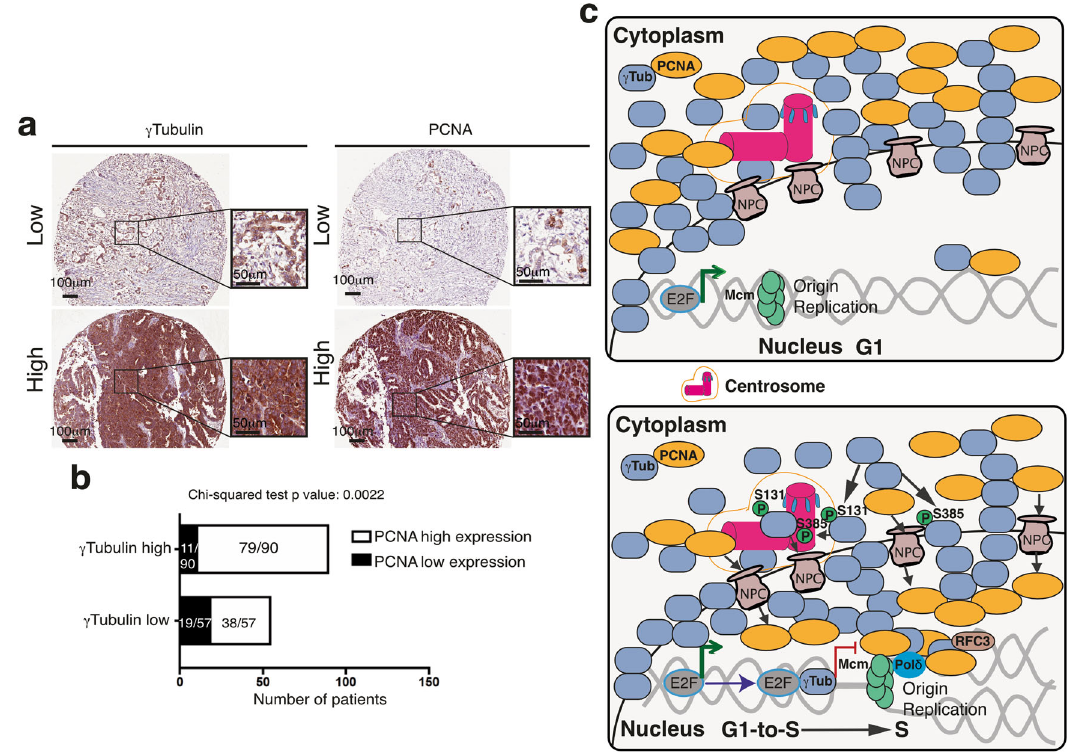
Fig. 10 Expression of γ -tubulin and PCNA in an ovarian cancer cohort. a Representative immunohistochemical staining of γ -tubulin and PCNA proteins. Staining is denoted as low or high. b Graph showing the relationship between the percentage of nuclei stained with PCNA and the levels of expression of γ - tubulin (see also Supplementary Fig. 12 and Supplementary Table 2). c Schematic representation of the different ways in which the γ -tubulin meshwork can control DNA replication. During nuclear formation, γ -tubulin establishes a nuclear protein boundary around chromatin that connects the cytoplasm and the nuclear compartment together. In G1 phase, the minichromosome maintenance complexes (MCMs) together with additional proteins are recruited to the origin of replication forming the pre-replication complex 45 . In S phase, the phosphorylation of γ -tubulin simultaneously initiates centrosomal duplication and increased nuclear γ -tubulin levels 2 – 4,20 – 24 . The E2F – γ -tubulin complex forms and terminates the transcriptional activity of E2Fs (red and green lines indicate inhibition